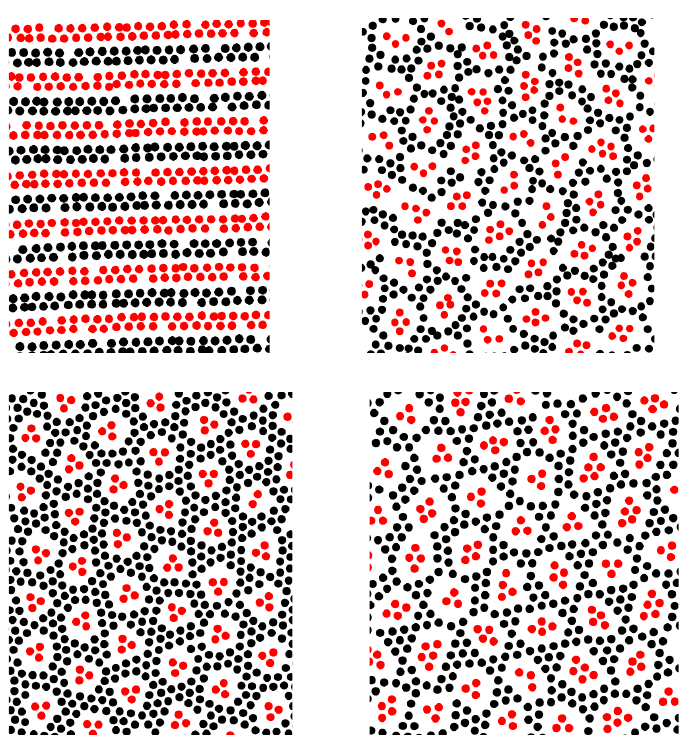
Figure 10. Representative configurations for the continuous model. A projection on the ( x , y ) plane of a layer of particles of thickness ∼ 1 a is shown for a part of the simulated system. The red and black circles represent the first and the second component. ( Left ) panel in the ( top ) row: the slab inside a monocrystal for q = 1 ( N 2 = N 1 ) at ¯ T = 0.14. ( Right ) panel in the ( top ) row: particles at the